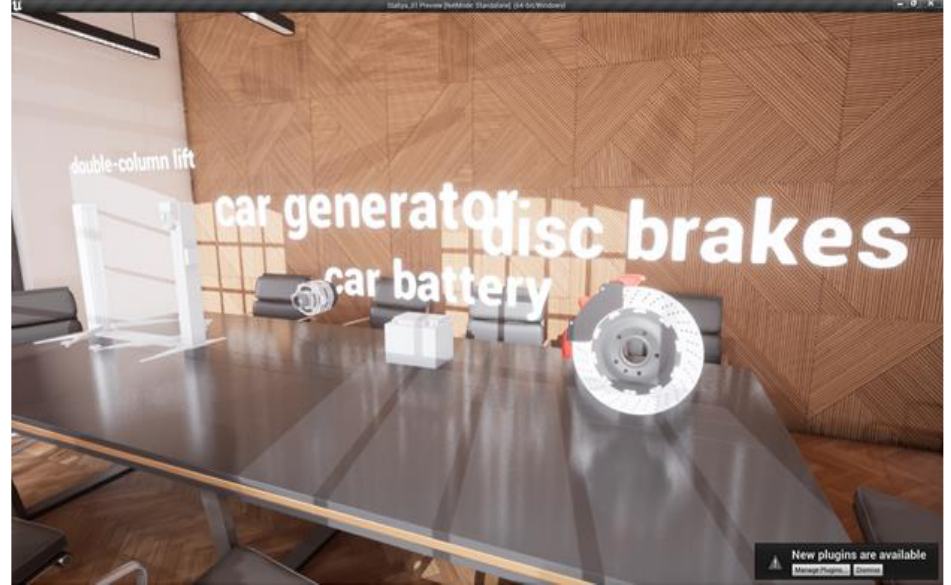
Figure 6. 3D object models.